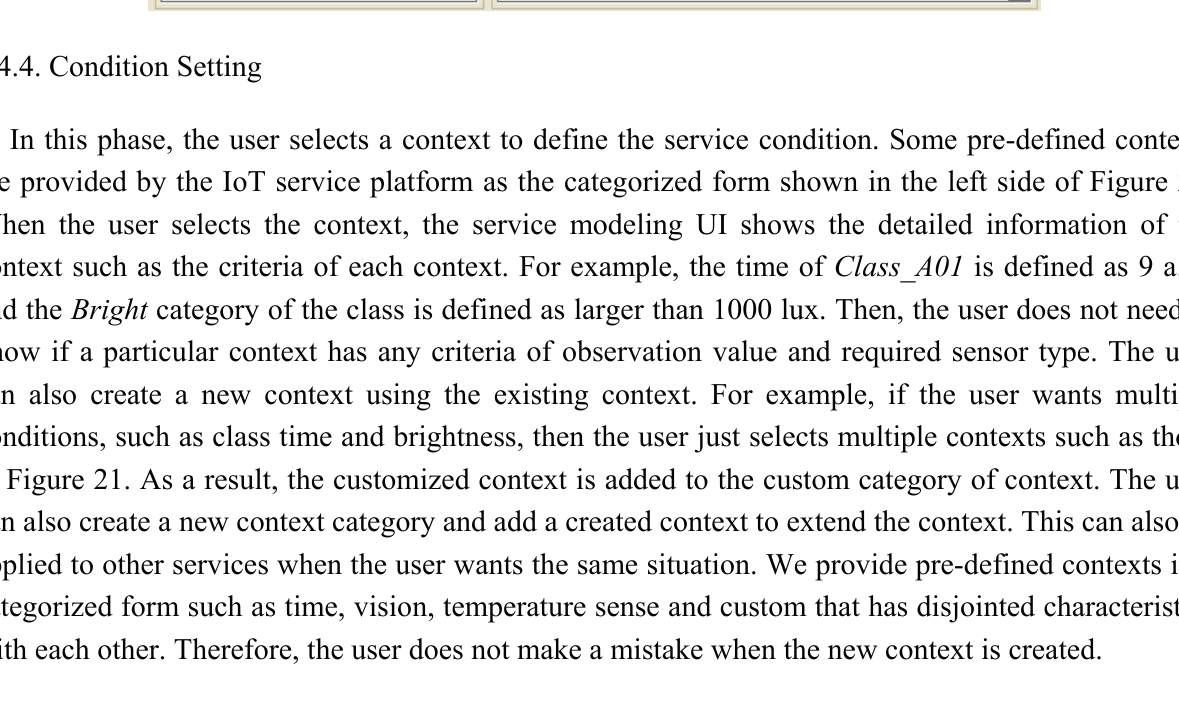
Figure 21. Web-based service modeling UI (Phase 4: condition